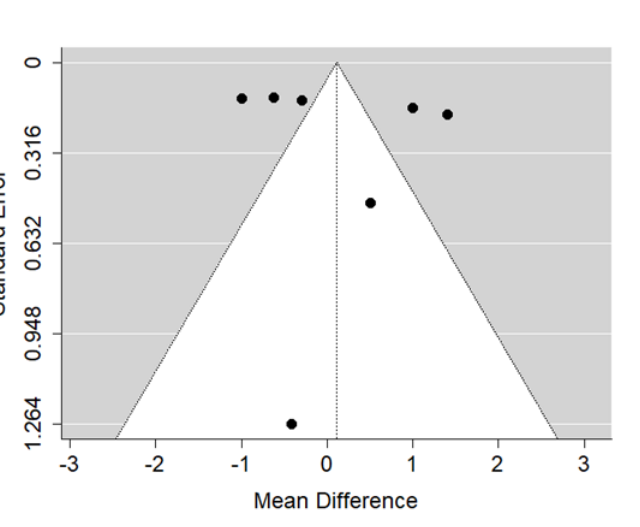
Figure 18. Forest plot of SNA values for the comparison of CPO patients of different age [20,23,30,32].